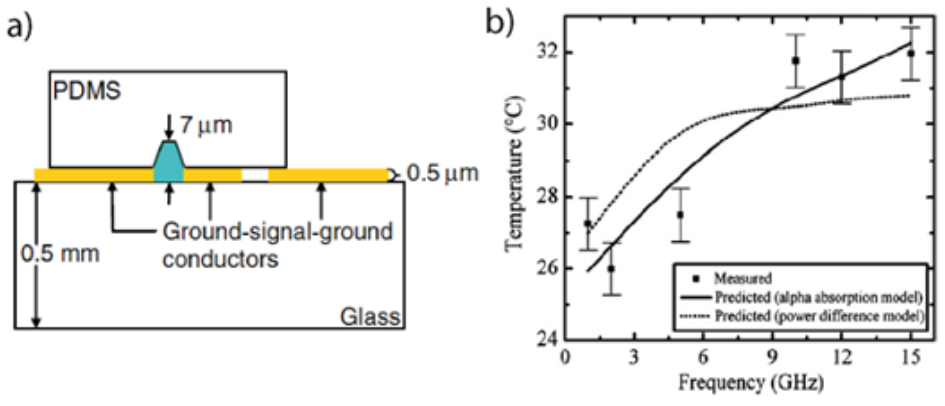
Figure 25. ( a ) Lateral view of a coplanar waveguide transmission line (yellow) surrounding a PDMS microchannel (blue). ( b ) Measured temperature (squares) of an aqueous solution as a function of frequency compared with two theoretical models (solid and dashed